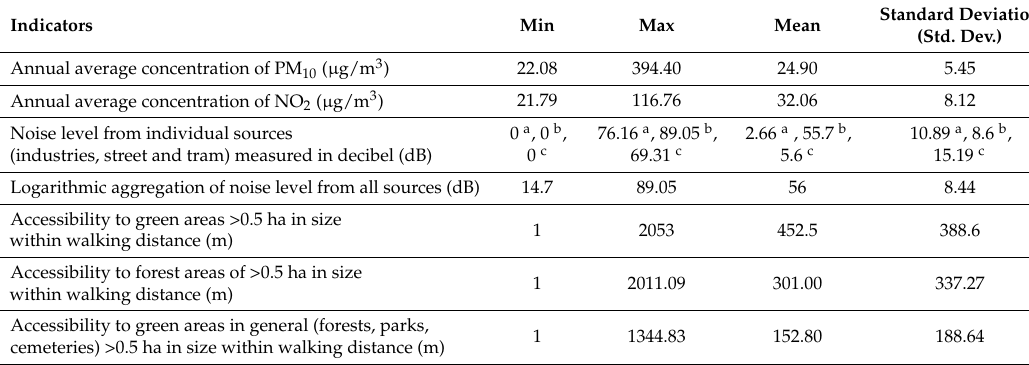
Table 5. Descriptive statistics for environmental indicators.